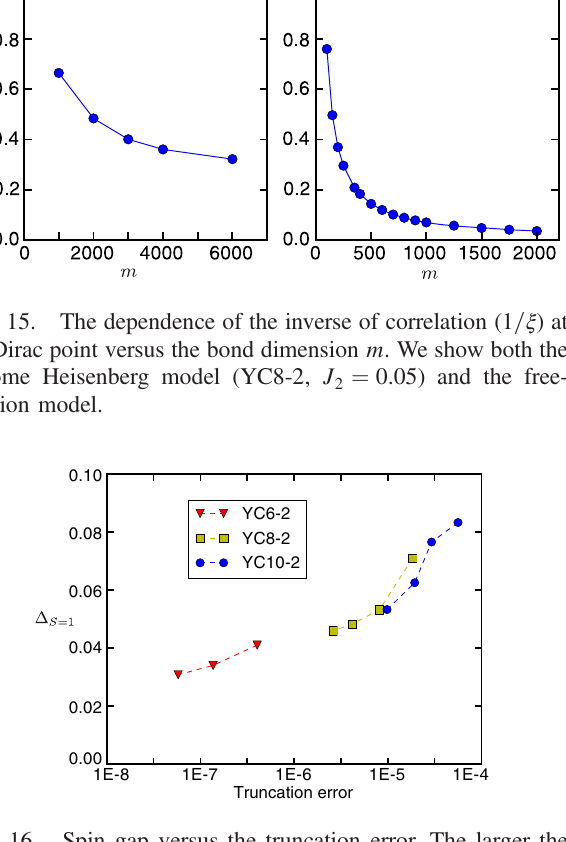
FIG. 16. Spin gap versus the truncation error. The larger the bond dimension is, the smaller the truncation error. For the comparable truncation error, the larger system size has a smaller spin gap. Here, we show J 2 ¼ 0 , and the twist angle θ ¼ 5 π = 6 . The bond dimensions shown are m ¼ 1000 , 2000, 3000, 4000. (For YC6-2, they are m ¼ 2000 , 3000,